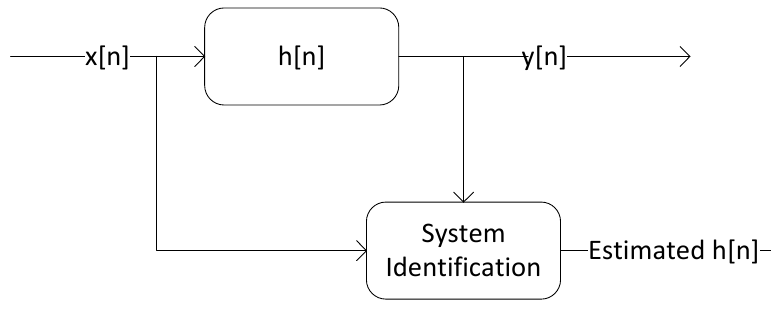
Figure 5. Model-free